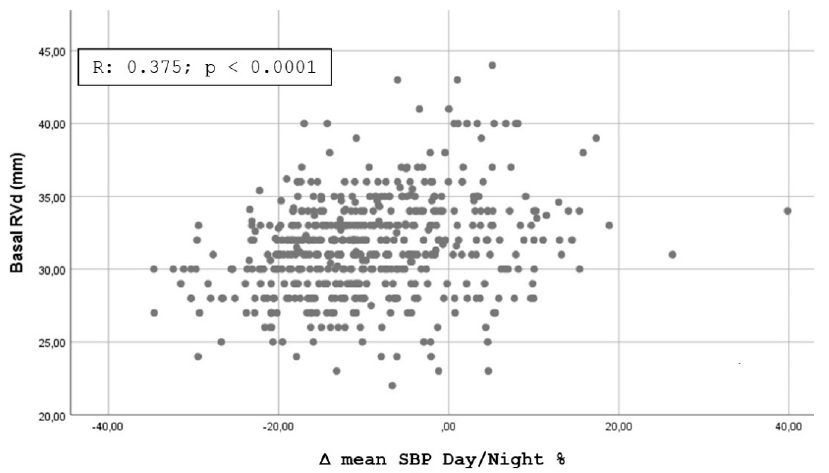
Figure 2. Scatterplot showing the Pearson’s correlation analysis for nocturnal reduction of blood pressure and Left Ventricle Mass Indexed.